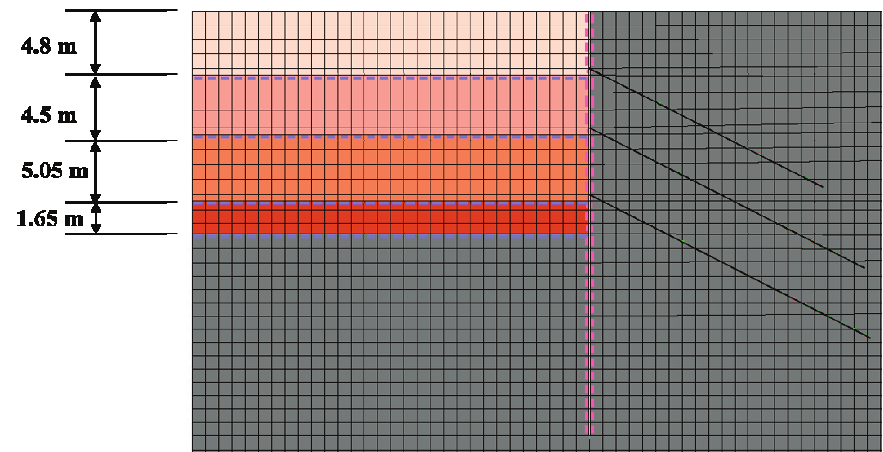
Fig. 14. Excavation stages considered in the FE simulation and the seepage surface elements applied at the bottom of each excavation level